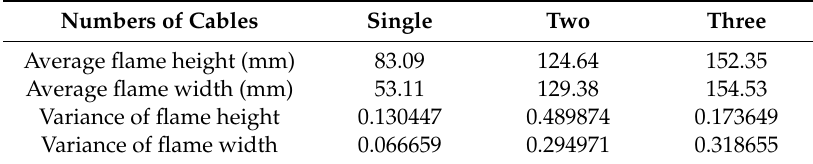
Figure 7. Flame size of multiple cables versus time. ( a ) Flame height; ( b ) flame width. Table 5. Average flame size of multiple cables with di ff erent cable